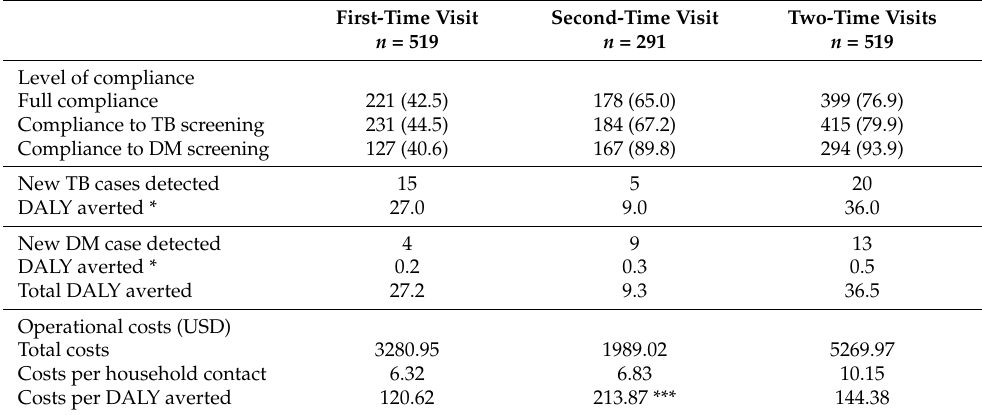
Table 1. Comparison of compliance, DALY averted, and operational costs between the first- and second-time